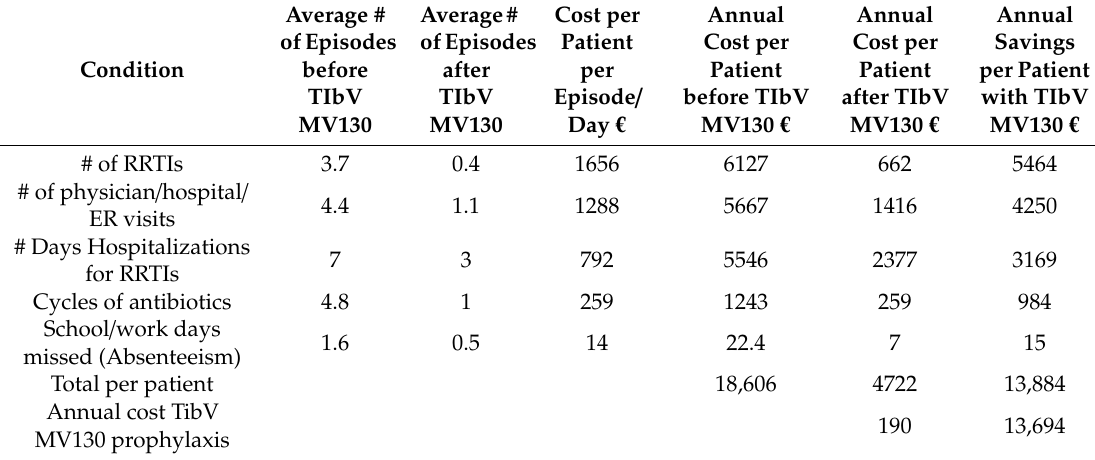
Table 1. Costs of the most frequent conditions a ff ecting CVID patients with RRTI—comparison of the year before and the year after the prophylaxis with TIbV (Euros). (#: number)